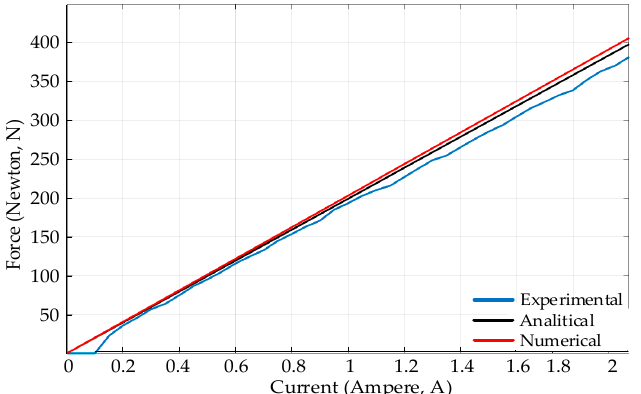
Figure 13. Force current ratio changes of CDCLM, K.